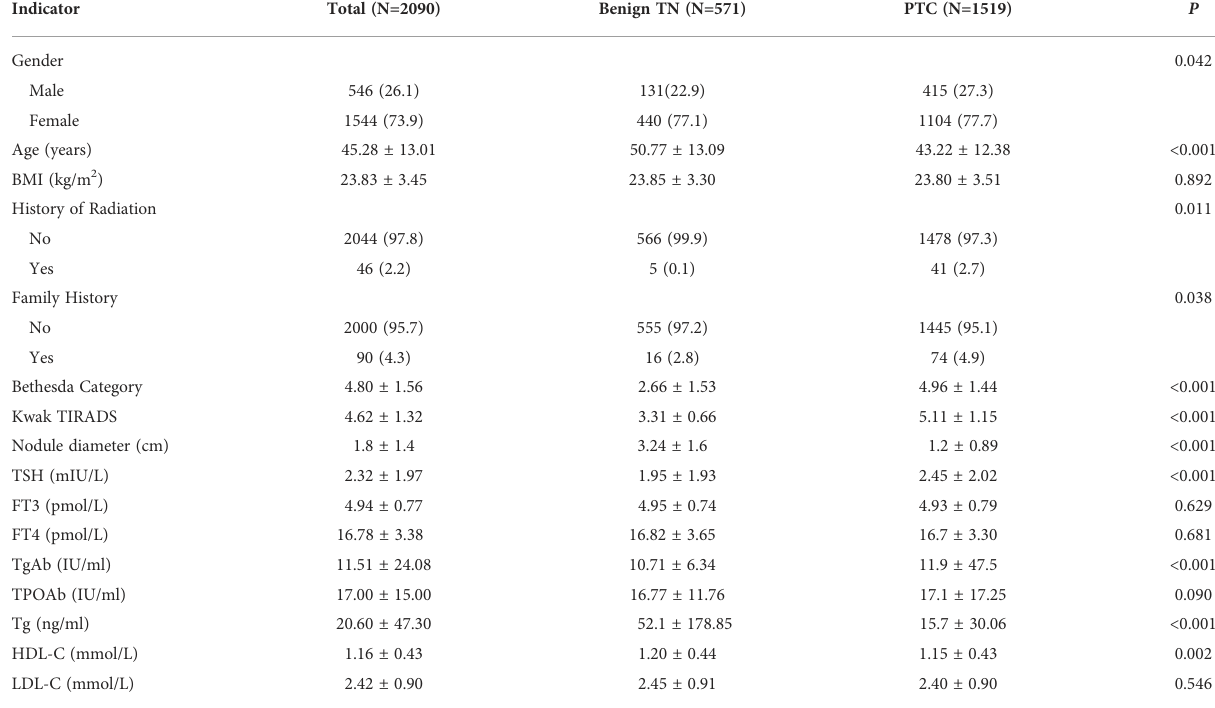
TABLE 1 Baseline characteristics of TN patients based on nodule